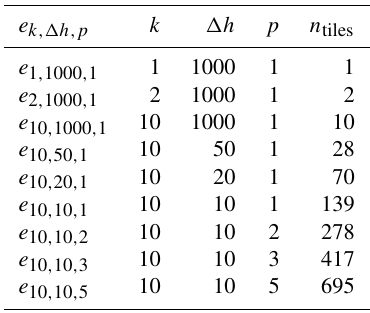
Table 1. Through a series of model experiments, the HMC param- eters are adjusted to assess their role in the modeled heterogene- ity. e k,(cid:49)h,p is the experiment id, k is the number of characteristic hillslopes, (cid:49)h is the difference in height between adjacent height bands, p is the number of intra-band clusters, and n tiles is the re- sulting number of